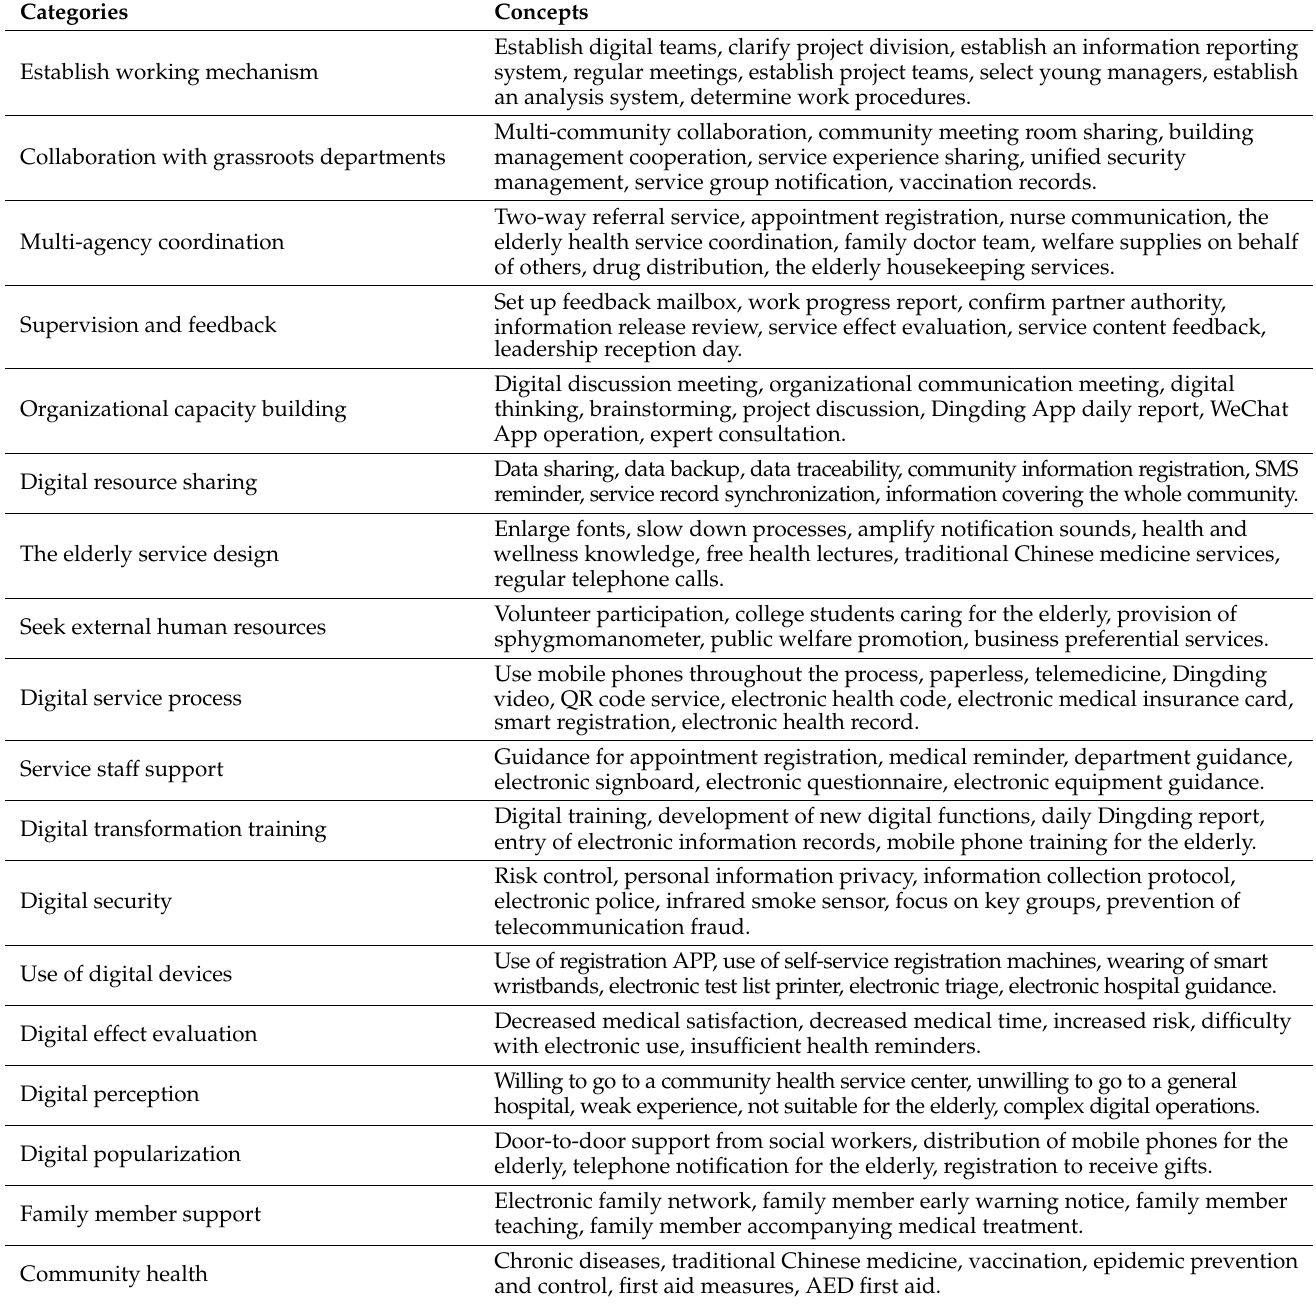
Table 7. Concepts and categories formed by open